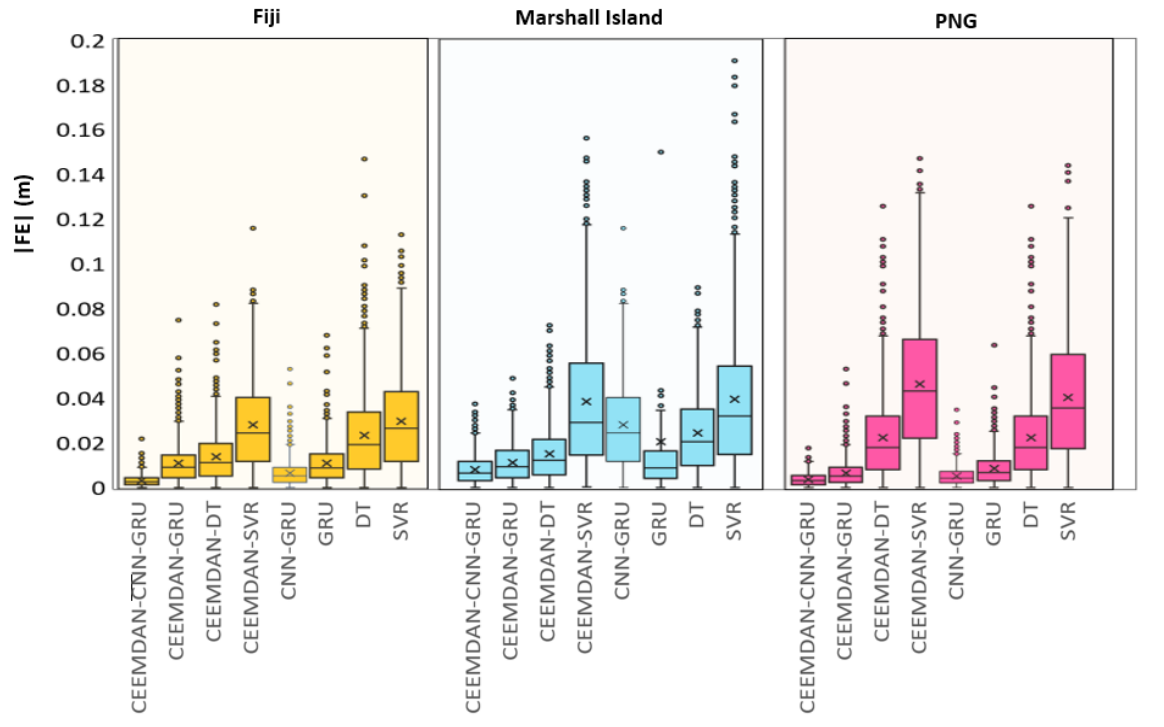
Figure 10. Box plots of hybrid models (CEEMDAN-CNN-GRU) along with their respective standalone counterparts (i.e., GRU, DT and SVR) in forecasted error (|FE|) in forecasting MSL of three selected Pacific Islands in the testing phase. The X symbol indicate the position of the mean in the box.